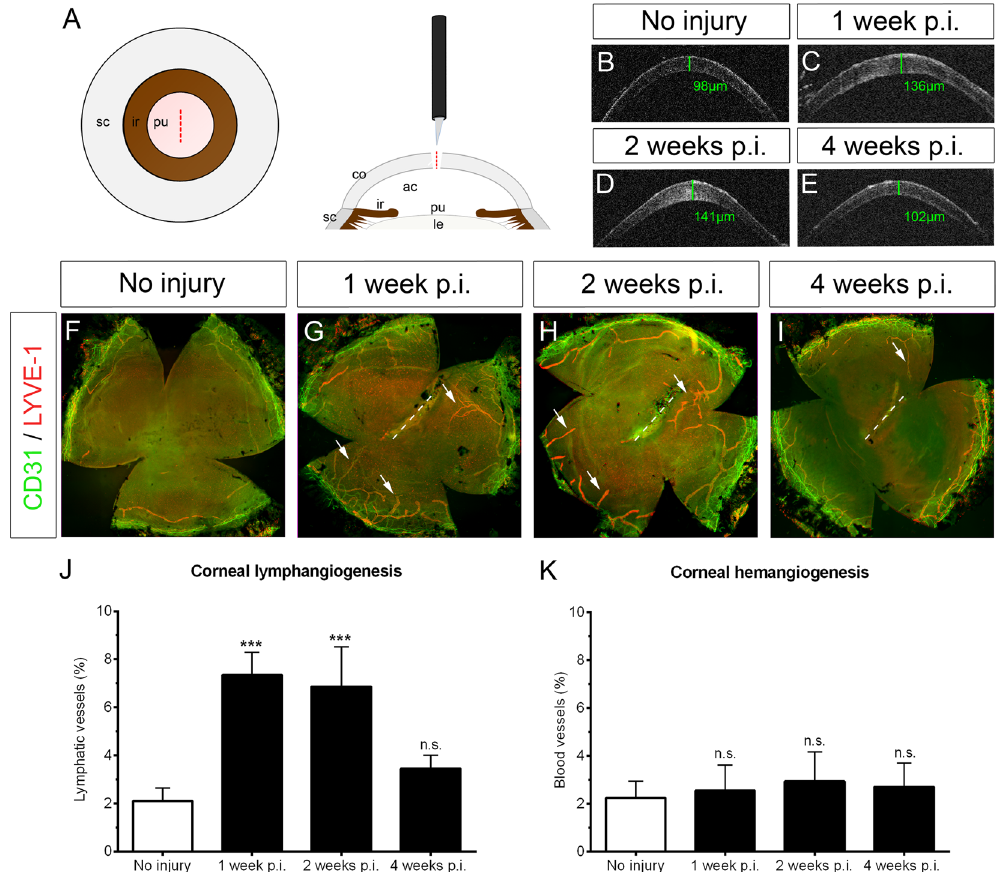
Figure 1. Corneal perforating incision injury induces transient edema and results in isolated lymphangiogenesis without hemangiogenesis. ( A ) Mouse model of central perforating corneal incision injury. After application of atropine to dilate the pupil and avoid iris incarceration, a linear perforating corneal incision (1.0 mm length) is performed (dashed lines). The lens and iris are not touched. Ac: anterior chamber; co: cornea; ir: iris; le: lens; pu: pupil; sc: sclera. ( B – E ) In vivo optical coherence tomography scans of the anterior segment demonstrate a transient increase of corneal thickness as a measure of corneal edema; green bars: areas of corneal thickness measurements; green values: central corneal thickness. ( F – I ) Corneal whole mounts stained with LYVE-1 (red) and CD31 (green); dashed lines: area of incision injury. LYVE-1 high /CD31 low lymphatic vessels (arrows) growing towards the central cornea are detectable 1 week after injury and persist until 2 weeks after injury. Afterwards, lymphatic vessels regress and the area covered by lymphatic vessels after 4 weeks is comparable to uninjured corneas. In contrast to lymphatic vessels, no significant ingrowth of LYVE- 1 neg /CD31 high blood vessels into the cornea is detectable; p.i.: post injury. ( J–K ) Quantification of corneal lymph- and hemangiogenesis; data are shown as mean + SD; n = 5–10 per time point; statistical analysis was performed using the unpaired 2-tailed Student’s t test: *** : p < 0.001; n.s.: not